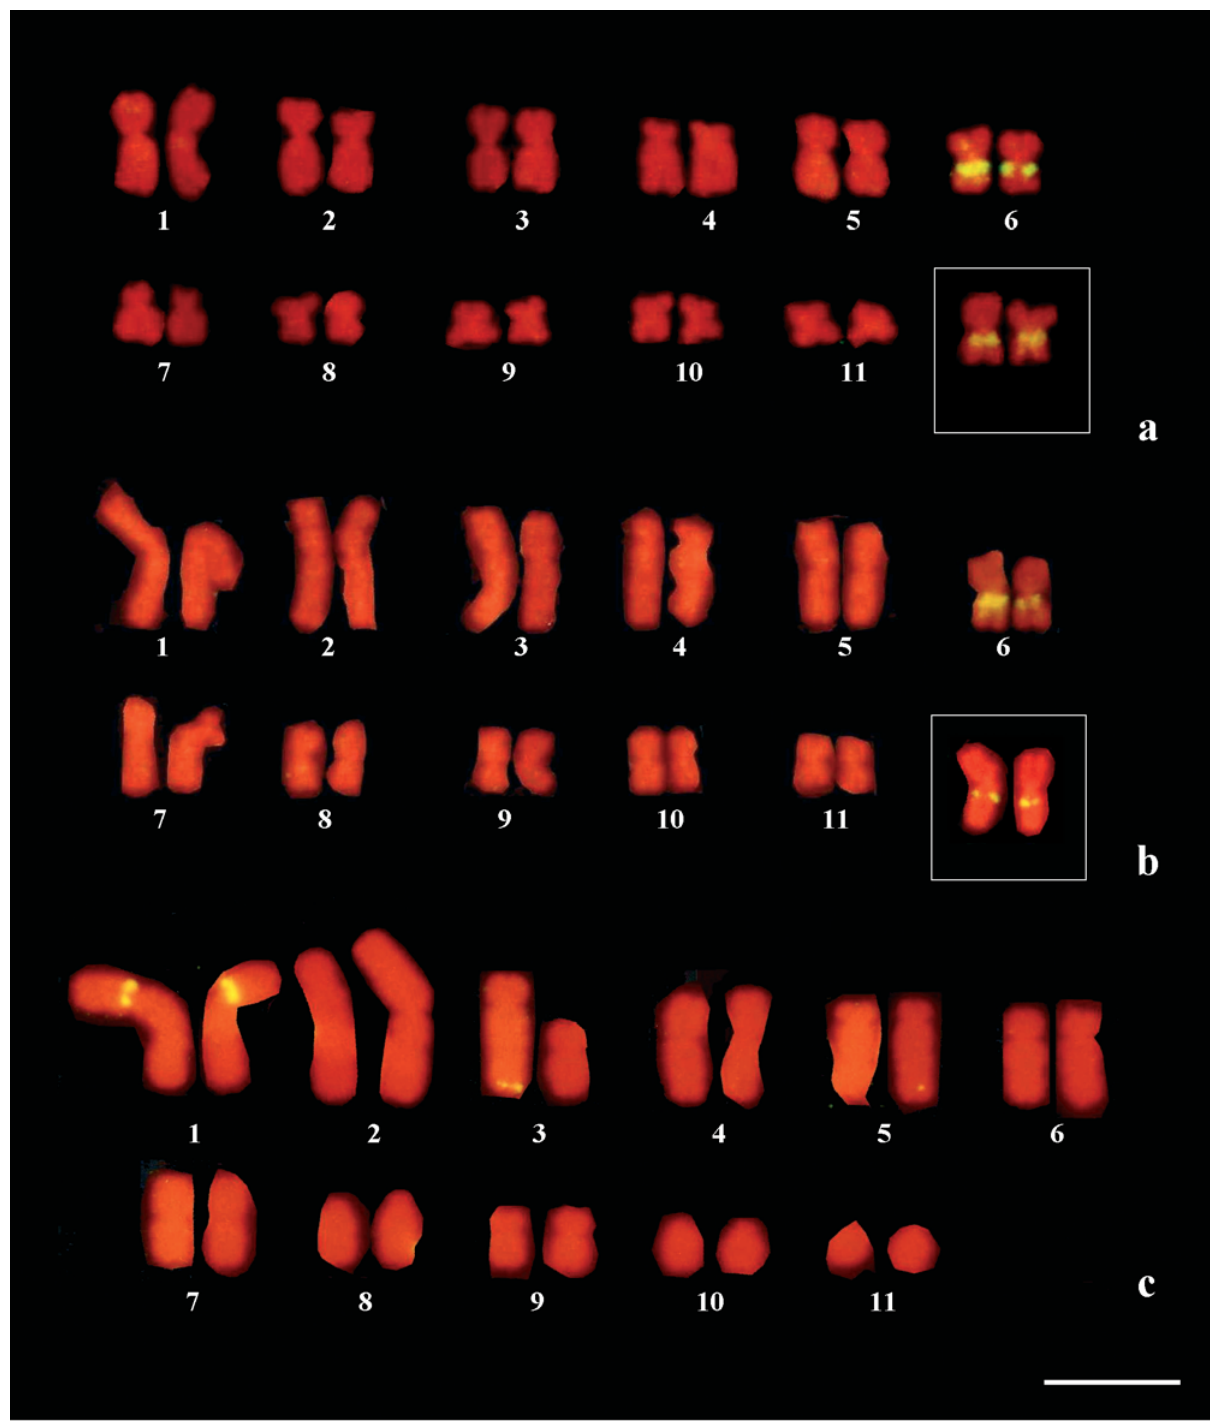
Figure 2 - Metaphases of E. guentheri ( a ), E. parvus ( b ) and E. binotatus ( c ) after fluorescence in situ hybridization with an rDNA probe. Note the addi- tional labeling in one of the homologues of pair 3 in E. binotatus . Bar = 10 µ